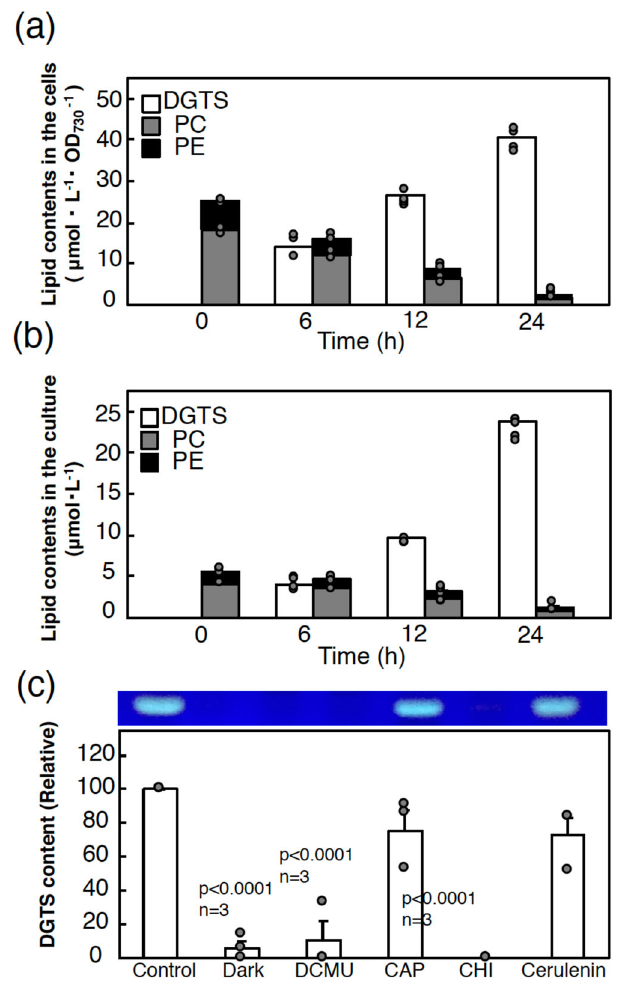
Fig. 6 Metabolic mechanism of DGTS accumulation under − P conditions. Changes in the contents of DGTS (white), PC (gray), and PE (black) in cells grown for 24 h after a shift from + P to − P conditions, which were estimated in cells on an OD 730 L culture basis ( a ), and in the culture ( b ). c Effects of metabolic inhibitors or light conditions on the accumulation of DGTS in the cells at 24 h after the shift to − P conditions. The values were estimated as the proportion of the DGTS content in the cells with application of chloramphenicol (CAP), cycloheximide (CHI), cerulenin, and DCMU, and in those shifted to the dark conditions, relative to that in non- treated control cells. The values shown are averages for two technical replicates for each of two biological replicates ( a , b ), or averages± SEM for three biological replicates ( c ). Some dots are overlapped (refer to source data in Supplementary Data 1). Data in ( c ) were analyzed by one-way ANOVA with multiple comparison by Tukey – Kramer ’ s